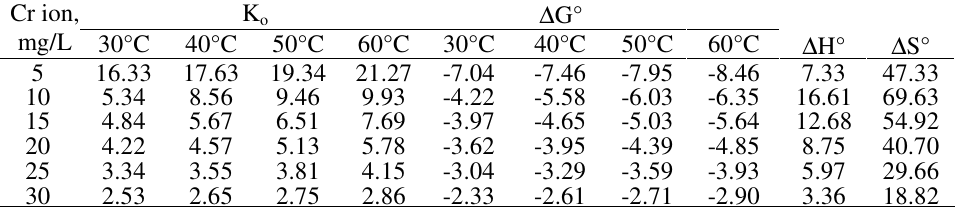
Table 6. Equilibrium constant and thermodynamic parameters for the adsorption of chromium ion onto acid activated